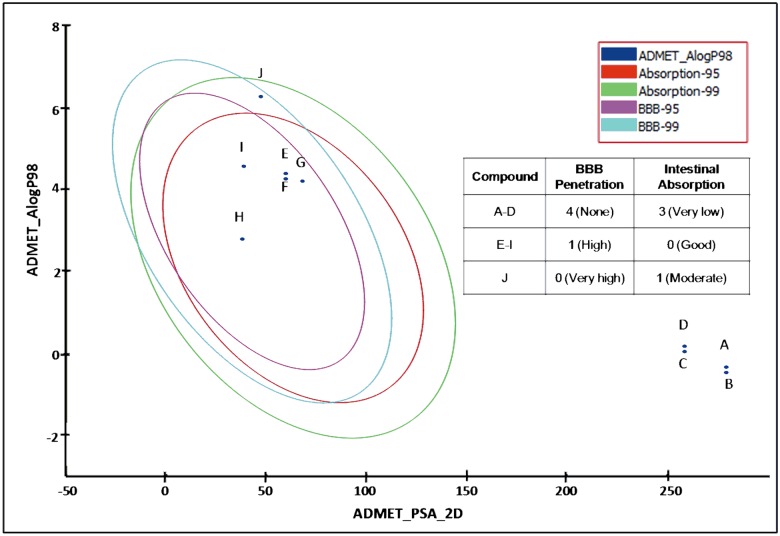
BBB penetration and intestinal absorption properties by ADMET descriptors.(A) bacoside A3, (B) bacopaside II, (C) bacopasaponin C, (D) bacopaside X, (E) jujubogenin, (F) pseudojujubogenin, (G) bacogenin A1, (H) tacrine, (I) donepezil and (J) ebelin lactone. Tacrine and donepezil were used as standard orally active CNS drugs. ADMET prediction level for Human intestinal absorption (HIA)- 0 (good), 1 (moderate), 2 (poor), 3 (very poor); Blood brain barrier (BBB)- 0 (very high penetrant), 1 (high), 2 (medium), 3 (low) and 4 (undefined). The aglycones and its acid hydrolysis derivatives showed better intestinal absorption and BBB penetration compared to the parent bacosides.